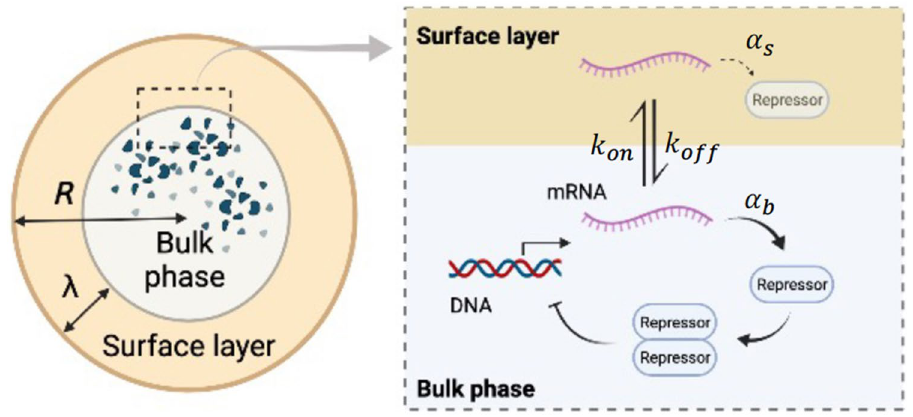
Figure 2. Schematic illustration of the TXTL reaction with negative autoregulatory feedback (NAF) control. The repressor protein synthesized by the TXTL reaction forms a dimer (equilibrium constant K 1 ). This dimer binds to the operator region of DNA (equilibrium constant K 2 ). NAF control is realized by reducing the transcription rate of mRNA from the DNA in which the repressor dimer is bound. Figure was created with